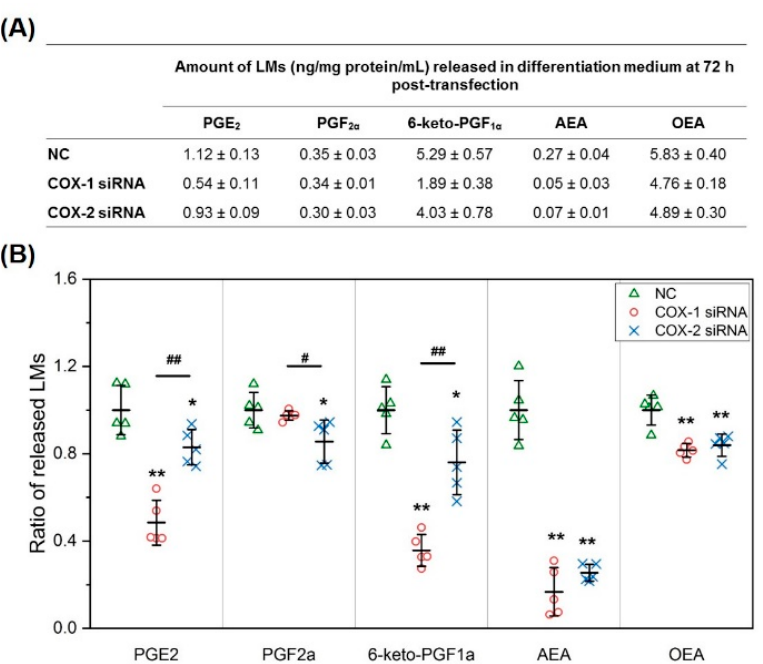
Figure 5. COX-1 or -2 knockdown reduces the levels of key lipid mediators released by C2C12 muscle cells. ( A ) Absolute quantification of LMs released in DM of C2C12; ( B ) ratio of LMs released in DM at 72 h post transfection comparing COX-1 siRNA or COX-2 siRNA treatment with NC transfection. n = 5, * p < 0.05 and ** p < 0.01 compared with NC; # p < 0.05 and ## p < 0.01 compared with COX-1 siRNA.